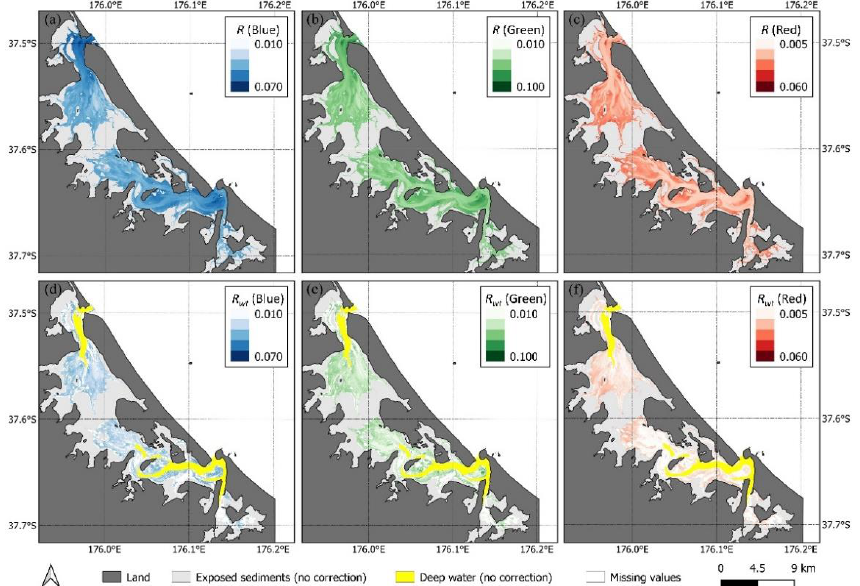
Figure 8. Maps of averaged reflectance of blue, green and red from the selected four images in inundated regions before ( a – c ) and after ( d – f ) correction using the temporal method (applied monthly). The reflectance before correction was averaged over four images in February 2019, so it could be better compared to the corrected maps, which are based on four images collected at different water depths. Reflectance in emerged (exposed sediment) regions and optically deep channels did not need correction, which are marked in grey and yellow, respectively. The missing values due to nonuniform input data are marked in white. Table 2. The STD and n of the R wt in visible bands after monthly, seasonal and annual correction, respectively.